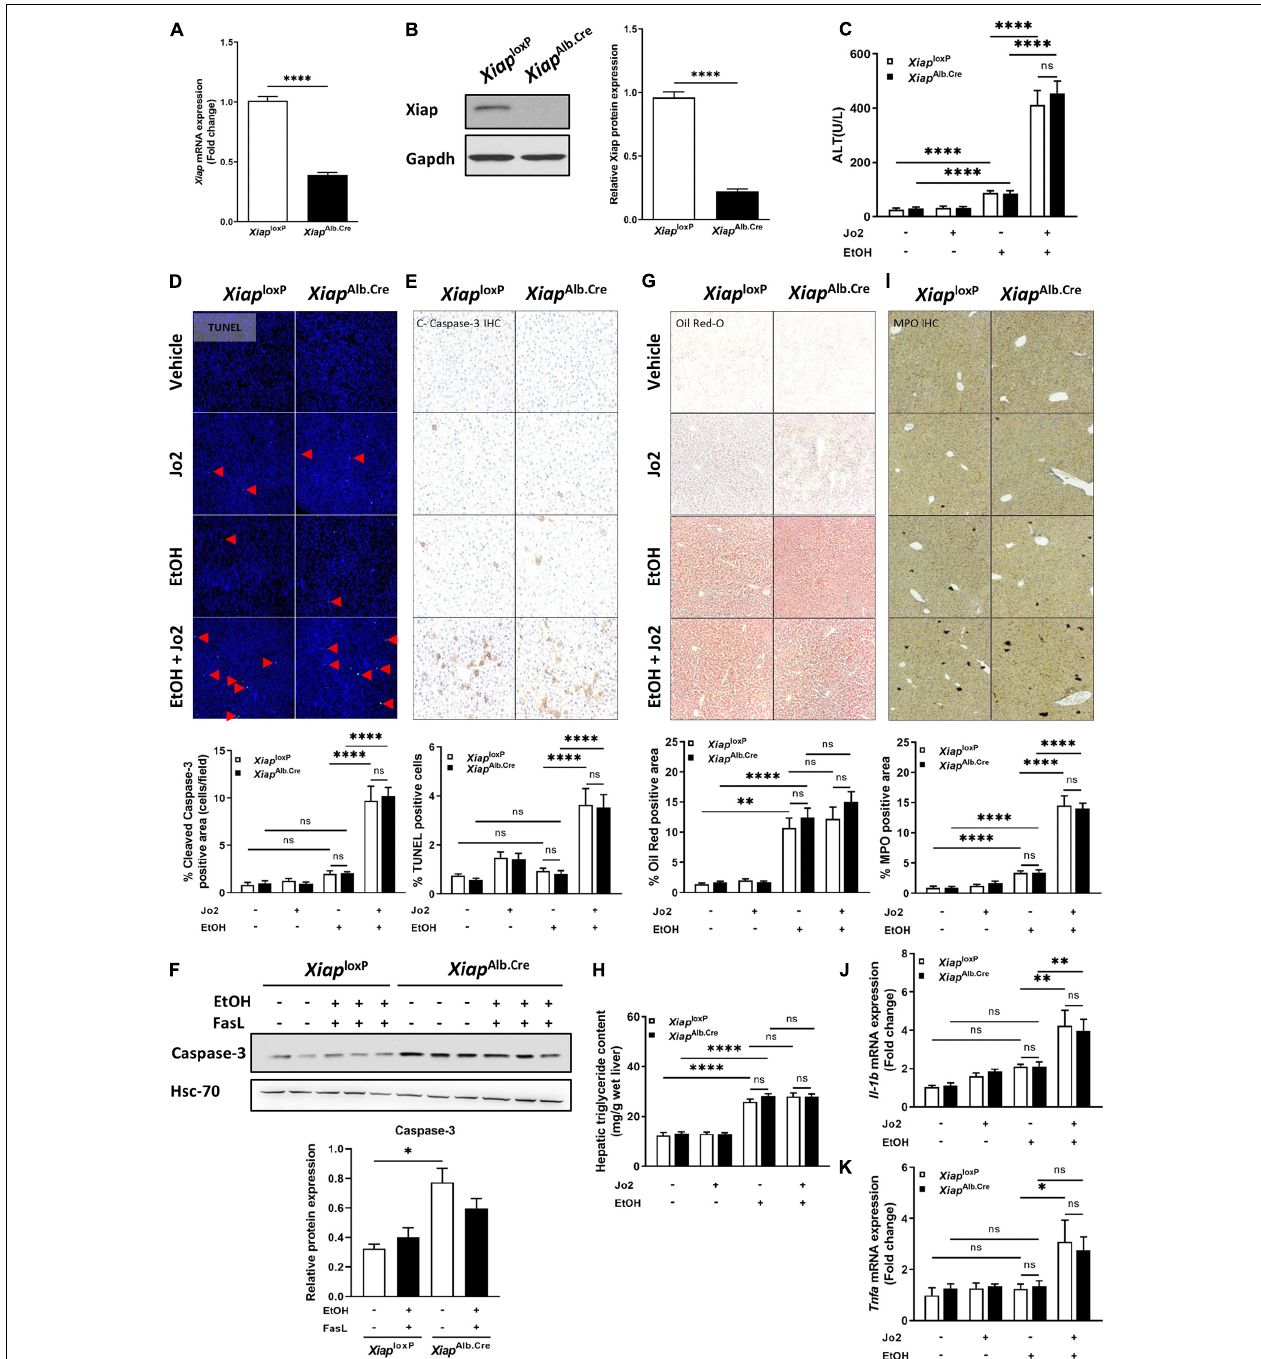
FIGURE 3 | Hepatocyte-specific genetic knockout of Xiap does not exacerbate injury in EtOH plus Jo2 mouse model. (A) Relative mRNA levels of Xiap determined by qRT-PCR in Xiap loxP - and Xiap Alb . Cre mice and expressed as fold change. β -actin was used as a housekeeping gene. (B) Protein levels of XIAP determined by Western blot in Xiap loxP - and Xiap Alb . Cre mice. GAPDH expression was used as a loading control for total protein. (C) Serum ALT levels from pair-fed and ethanol-fed mice with and without Jo2 administration. (D,E,G,I) Histological evaluation of the role of Xiap in liver tissues collected from Xiap loxP - and Xiap Alb . Cre mice that underwent ethanol or paired-feeding and were administered saline or Jo2. TUNEL (D) , cleaved-Caspase-3 IHC (E) , Oil Red-O staining (G) , and MPO IHC (I) were performed. Representative images and quantifications from mice are shown. Image magnification 10X. (F) Protein expression of Caspase-3 determined by Western blot in liver tissue from Xiap loxP - and Xiap Alb . Cre mice that underwent ethanol or paired-feeding. Representative image is shown. Hsc-70 protein levels were used as a loading control for total protein. (H) Hepatic triglyceride (TG) levels expressed as mg/g of wet liver weight. (J,K) Relative mRNA levels of Il-1b (J) and Tnfa (K) as determined by qRT-PCR in Xiap loxP - and Xiap Alb . Cre mice and expressed as fold change. b-actin was used as a housekeeping gene ( ∗ p < 0.05; ∗∗ p < 0.01; ∗∗∗ p < 0.005; ∗∗∗∗ p < 0 . 001; ns, no significance, and n = 3–6).